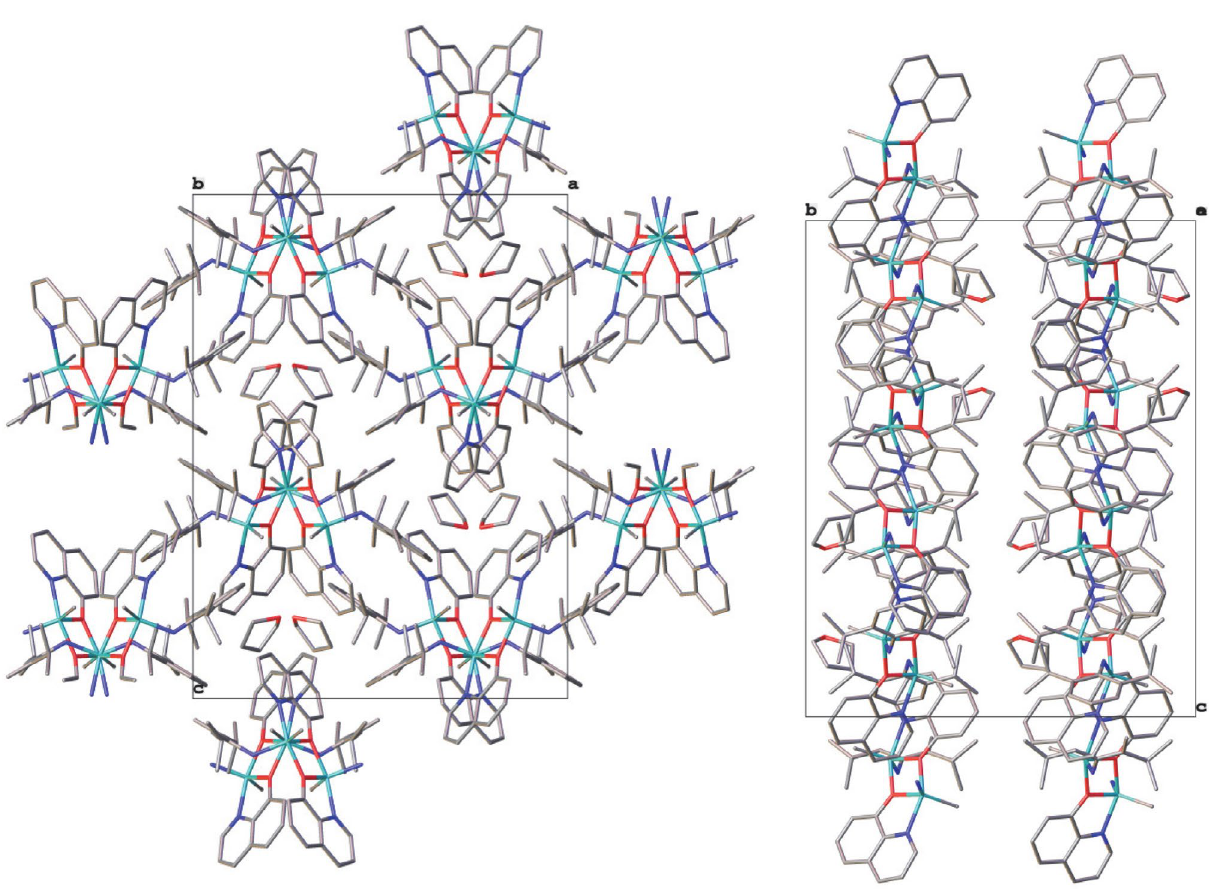
Figure 2. Packing in the unit cell of 2 , viewed along b -crystallographic axis (left) and a -crystallographic axis (right), hydrogen atoms were omitted for clarity